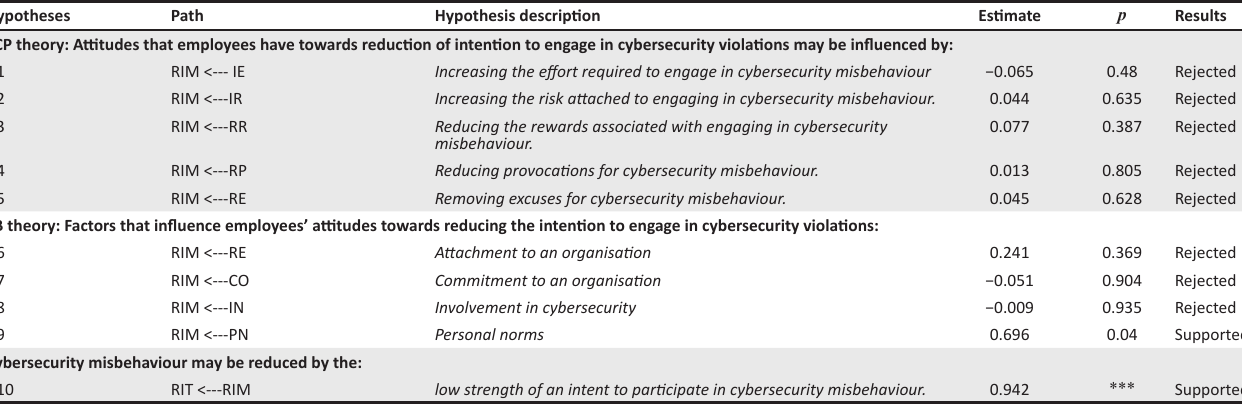
TABLE 1: Hypothesis test results. Hypotheses Path Hypothesis description Estimate p Results